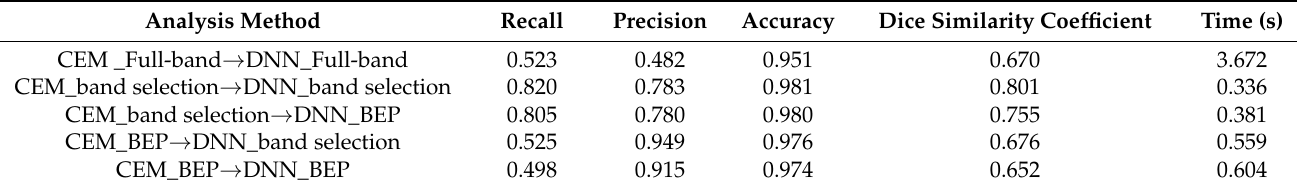
Table 4. Evaluation metrics of DNN prediction. The best performance is highlighted in red